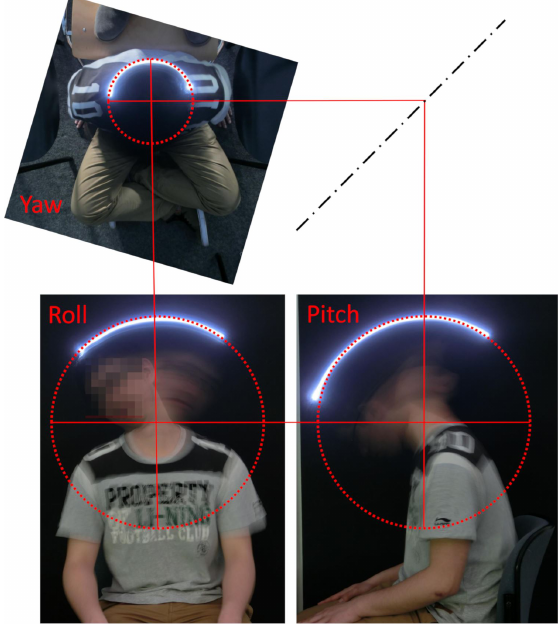
Figure 1. Kinematics of the cervical spine. From the kinematic point of view, the human cervical spine can be approximated by a ball joint. That means, every motion can be divided into single rotations around three orthogonal axes that intersect in one point. This point, that is, the center of rotation, roughly coincides with the location of the thyroid gland. As a result, a rigid body placed onto a human head moves on a spherical surface during head